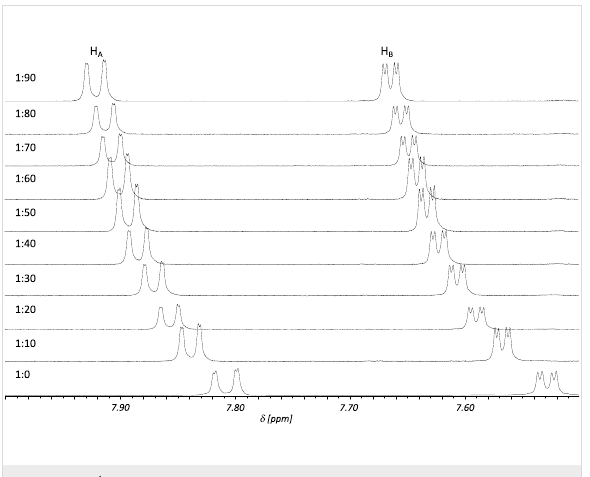
Figure 2: 1 H NMR titration (500.1 MHz, 298 K, c 0 ( 2 ) = 5.3 mmol/L) of 2 with increasing amounts of ethyl acetate. H A and H B are both signals of protons of the 2,2′-bipyridine (see Supporting Information for further details).